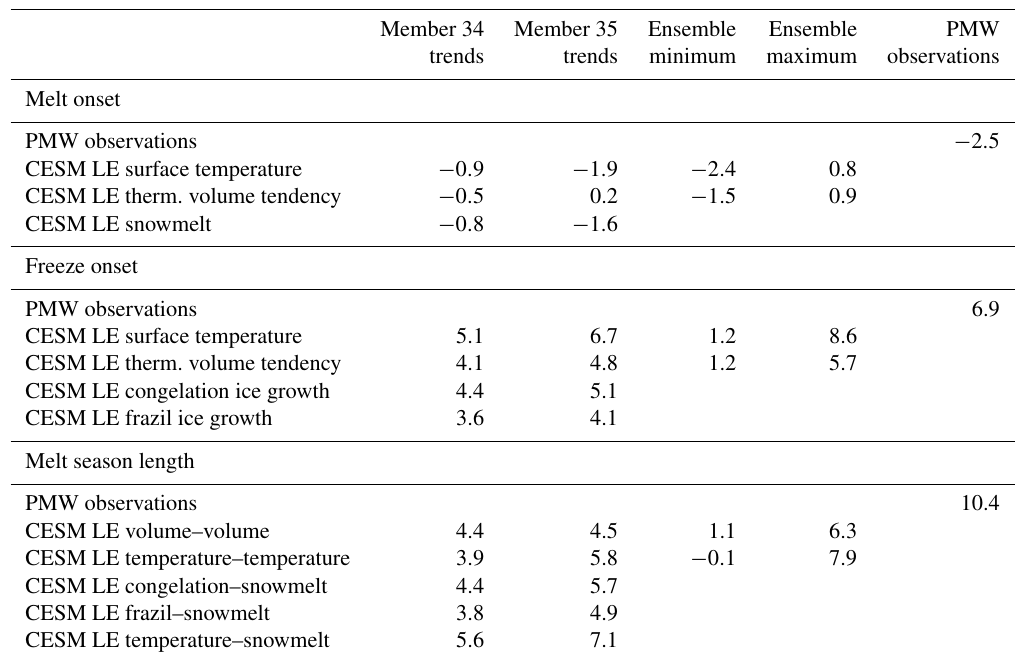
Table 3. Trends in pan-Arctic melt onset, freeze onset and melt season length (daysdecade − 1 ) over 1979–2014 using PMW observations and CESM LE